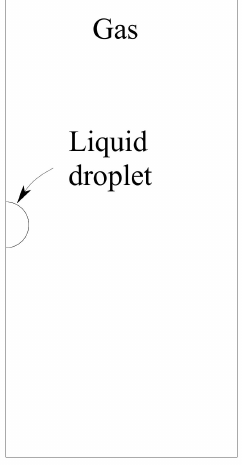
Figure 1. Computational